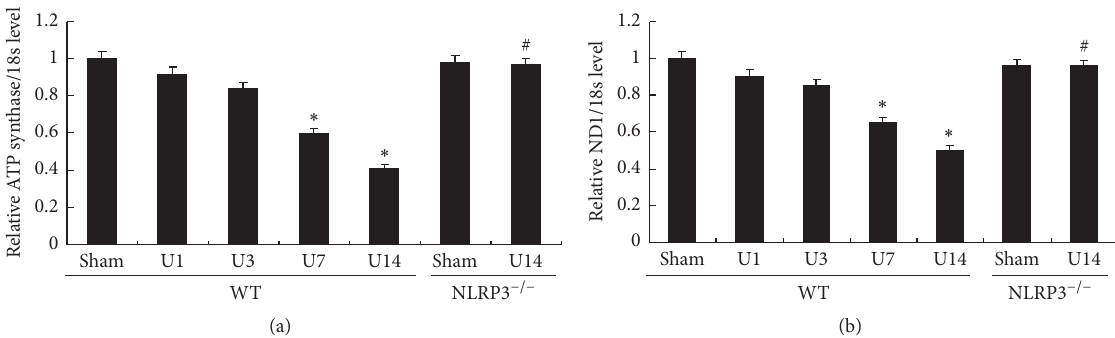
Figure 8: NLRP3 deletion attenuates UUO-induced mitochondrial dysfunction. Semiquantitative analysis of ATP synthase (a) and ND1 (b) normalized against 18S performed by real-time PCR. Data represent the mean ± SEM ( 𝑛 = 6 ). ∗ 𝑃 < 0.05 , compared with WT/Sham group, # 𝑃 < 0.05 , NLRP3 −/− /U14 group versus WT/U14 group. U1, U3, U7, and U14 indicate that mice were sacrificed on days 1, 3, 7, and 14 after